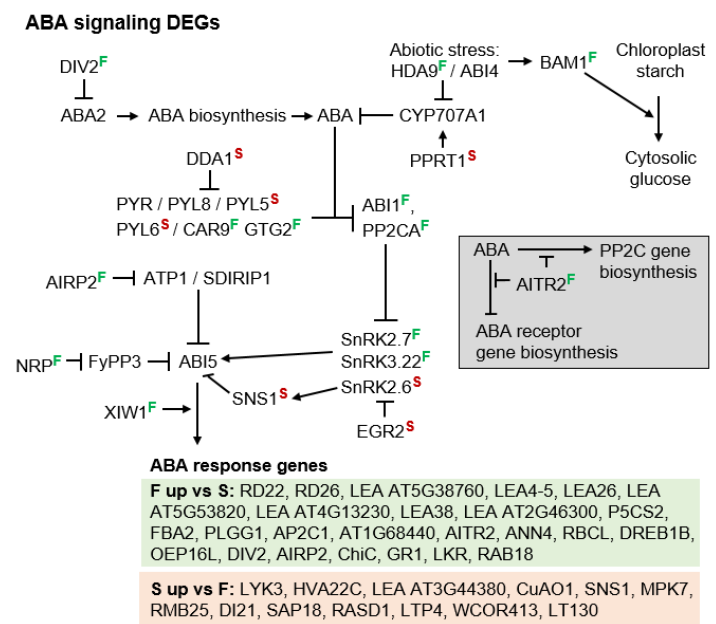
Figure 6. ABA signaling associated differentially expressed genes (DEGs) observed between diplosporous Boechera × formosa and sexual Boechera stricta (see Tables S5 and S9). Superscripts identify taxa in which DEGs are upregulated; F, B. × formosa ; S, B. stricta ; red and green highlights, up and down-regulation in B. stricta , respectively; arrows indicate upregulation or activation; blunt end lines represent downregulation or suppression.